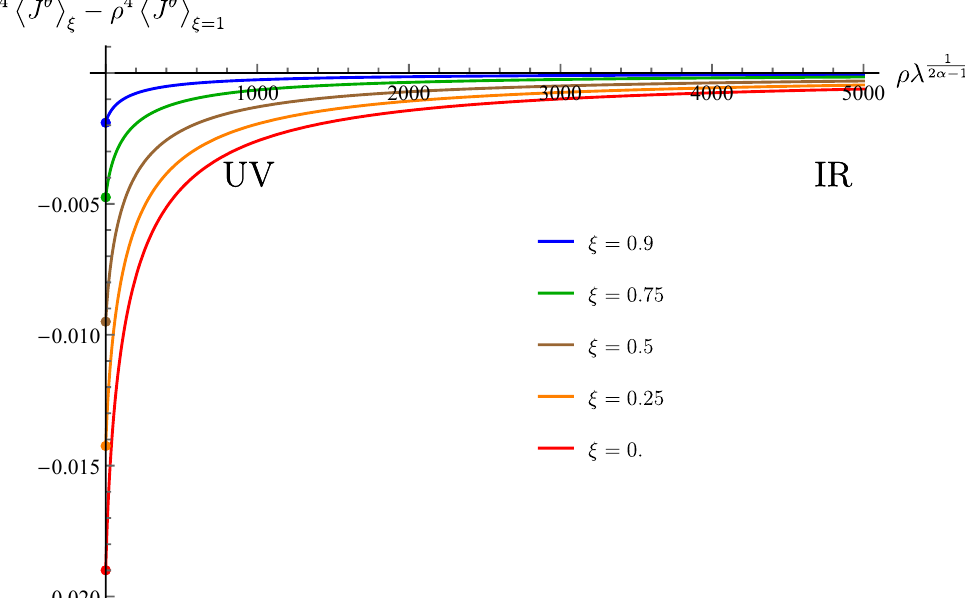
Figure 3. The quantity ρ 4 different values of ξ . While in the UV the quantity depends on ξ , in the IR limit all the curves go to